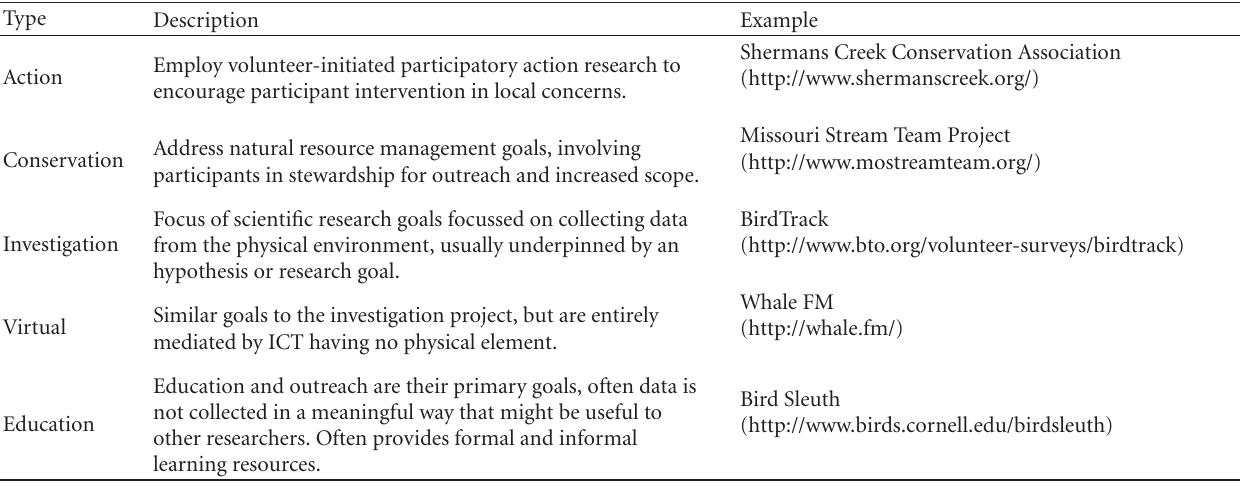
Table 1: Citizen science typologies as described by Wiggins and Crowston [1].